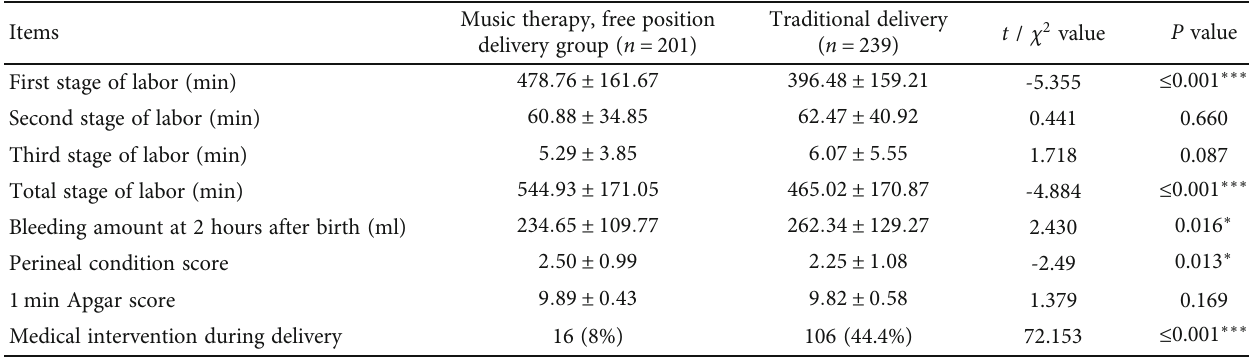
Table 3: Maternal and fetal outcomes in the two groups.